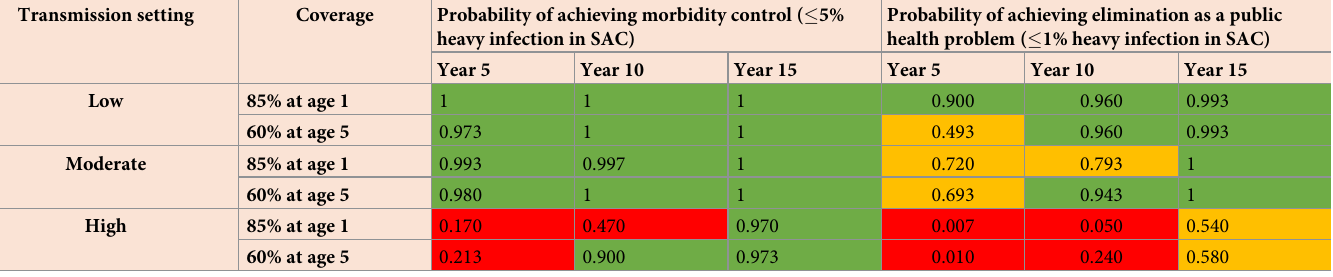
Table 7. Probability of reaching the WHO 1% elimination as a public health problem goal and the SAC 5% morbidity goals, when MDA and vaccination are admin- istrated concurrently; 75% SAC coverage (annually in high settings, once every 2 years in moderate settings and once every 3 years in low settings) and the vaccine duration of protection is set at 20 years. Green shaded areas = probability of reaching target > 0.9, Yellow shaded areas = 0.5 � probability of reaching target < 0.9, Red shaded areas = probability of reaching target < 0.5. Transmission